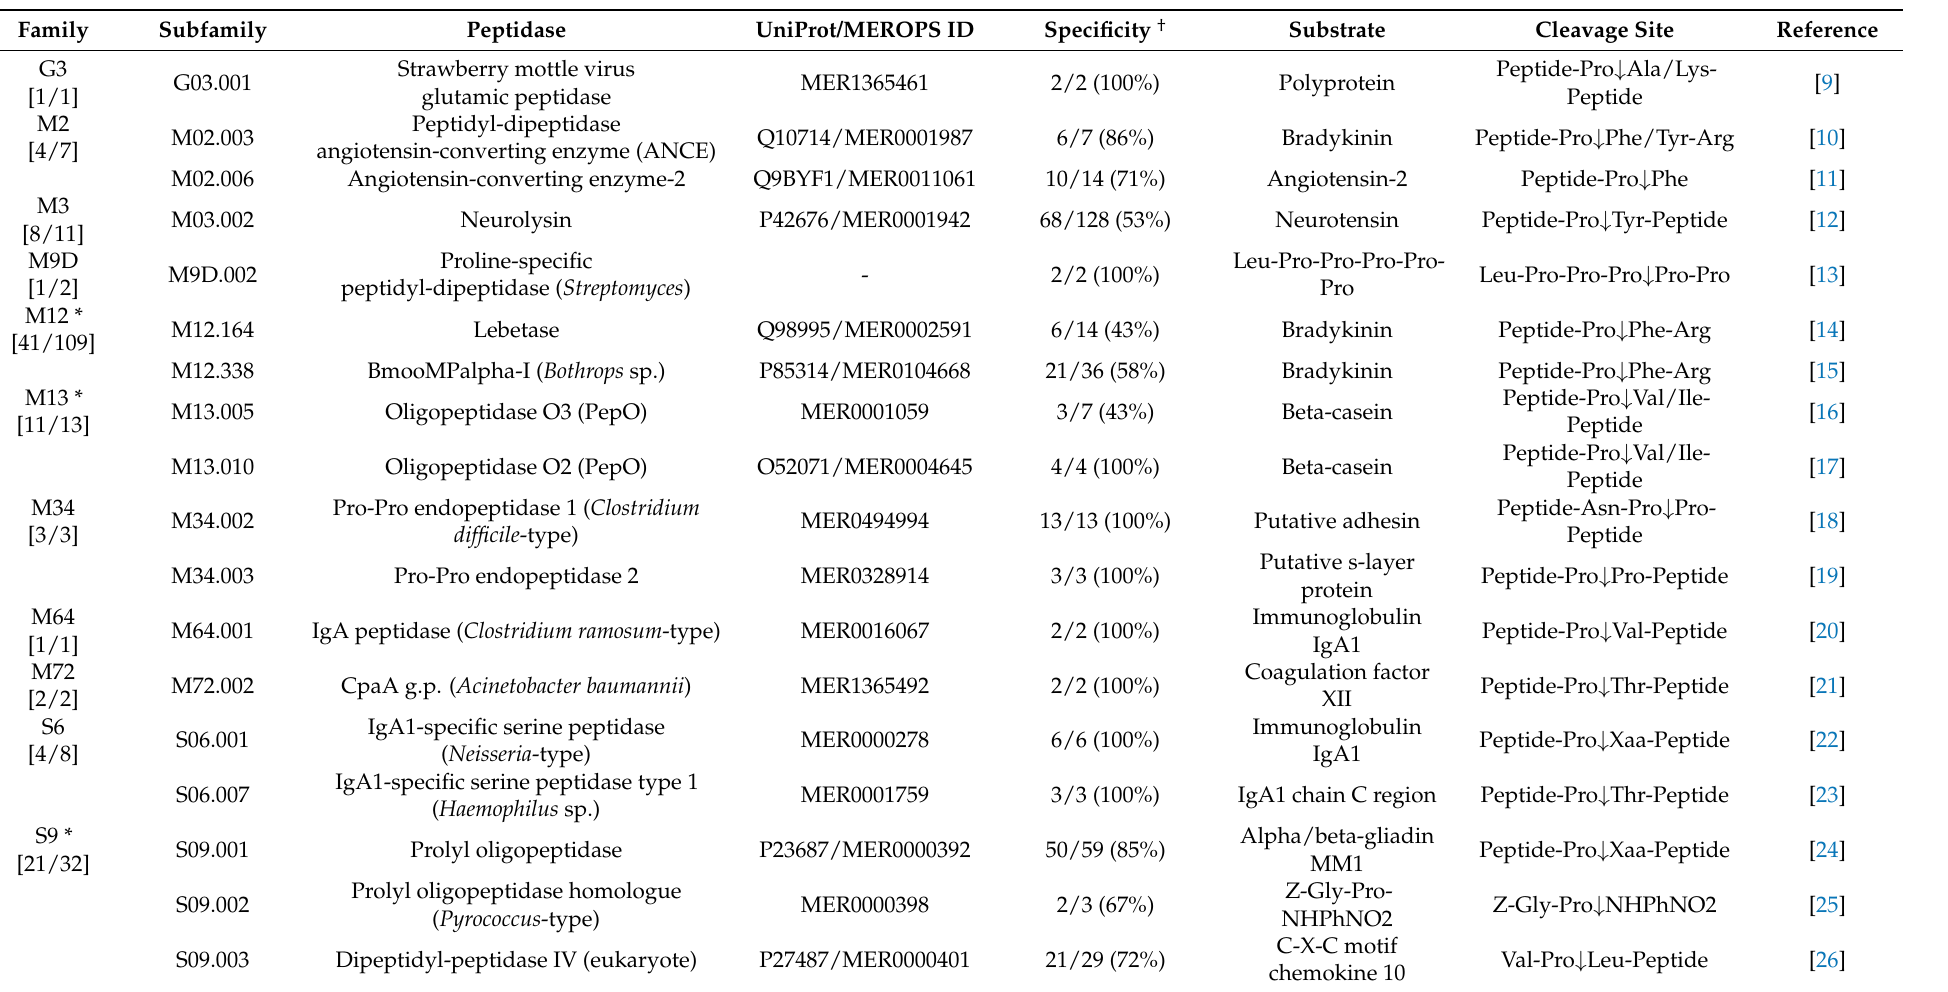
Table 1. A non-exhaustive list of selected enzymes with post-proline cleaving activity based on records from the MEROPS peptidase database release 12.4.